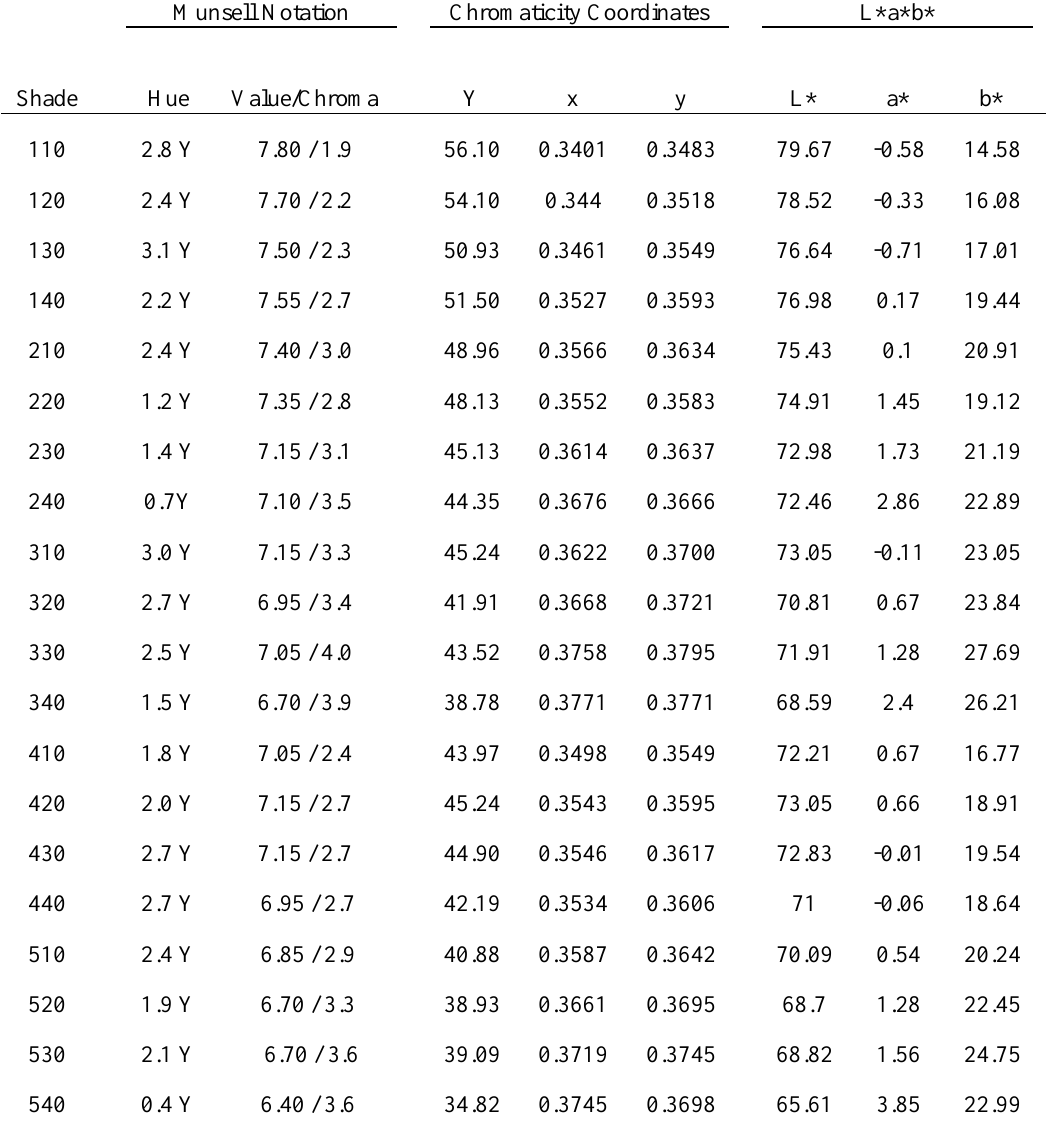
Table 1. Color parameters of Chromascop master shade